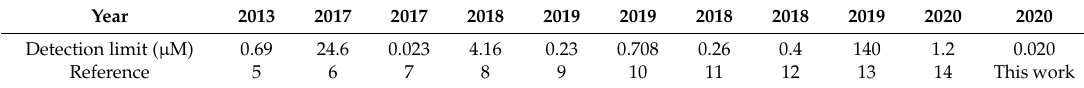
Table 1. Comparison of the detection limit of the recently reported CNDs probes for Cr(VI).